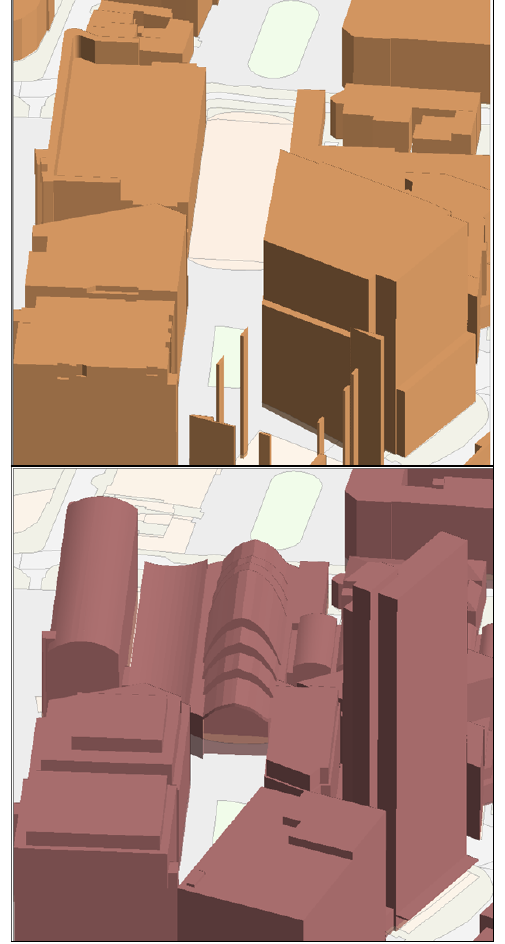
Figure 5: An example of an LoD 2 building (a glasshouse, bot- tom) not included in the LoD 1 dataset (top)